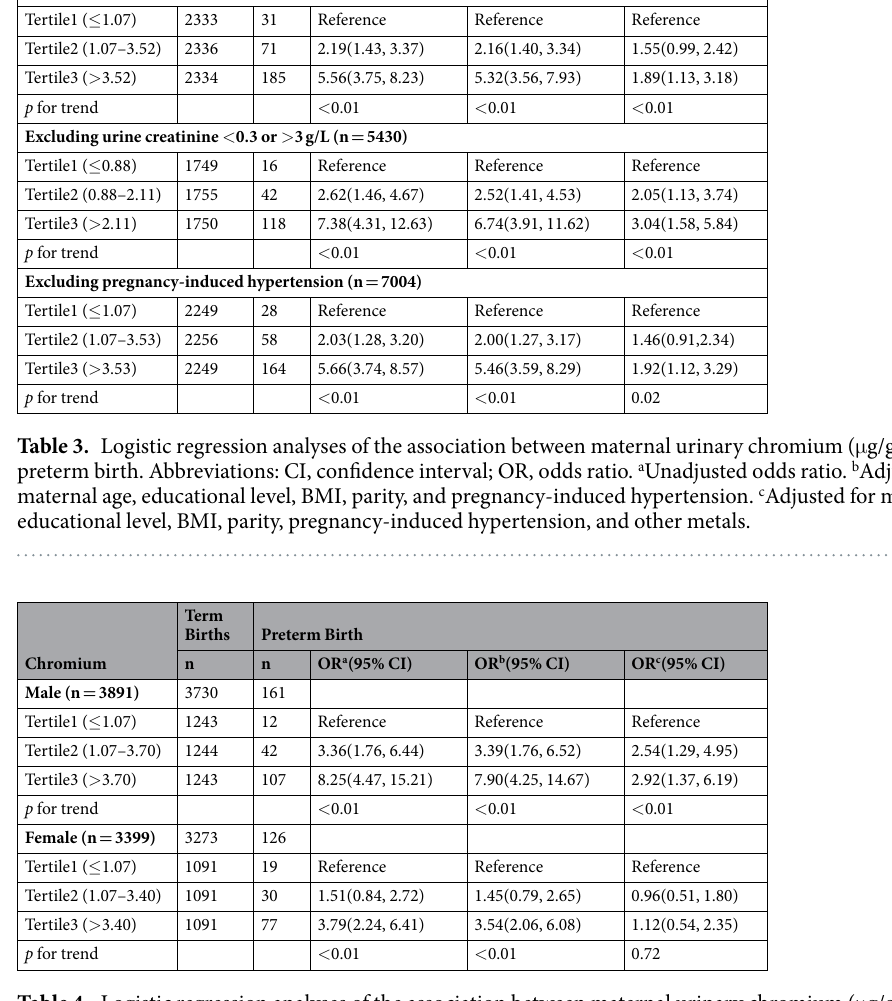
Table 4. Logistic regression analyses of the association between maternal urinary chromium ( μ g/g cr) and preterm birth, stratified by infant gender. Abbreviations: CI, confidence interval; OR, odds ratio. a Unadjusted odds ratio. b Adjusted for maternal age, educational level, BMI, parity, and pregnancy-induced hypertension. c Adjusted for maternal age, educational level, BMI, parity, pregnancy-induced hypertension, and other